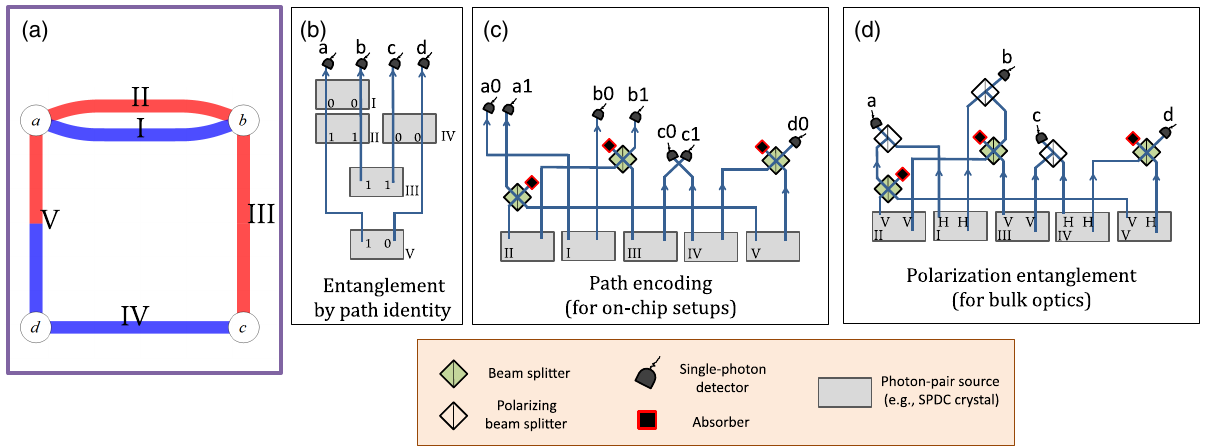
FIG. 9. Translation of a graph to three different types of quantum optics experiments. (a) A graph with four vertices and five edges and two colors represents a four-photon quantum experiment using two state levels (dimensions), such as polarization. (b) Implementation using entanglement by path identity. (c) Implementation using path encoding, which is the most commonly used encoding for on-chip quantum optics experiments. (d) Implementation using bulk optics for polarization quantum optics experiments.